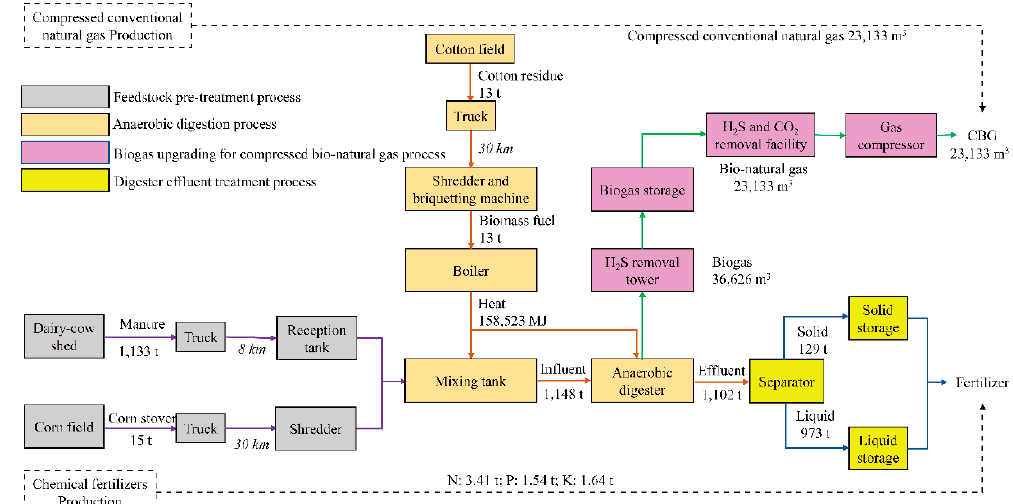
Figure 1. Key processes and data flows per day within the system boundary of the cattle manure co-digested with corn stover for the large-scale compressed bio-natural gas (CBG) production. Dotted lines indicate the replaced energy and fertilizer.